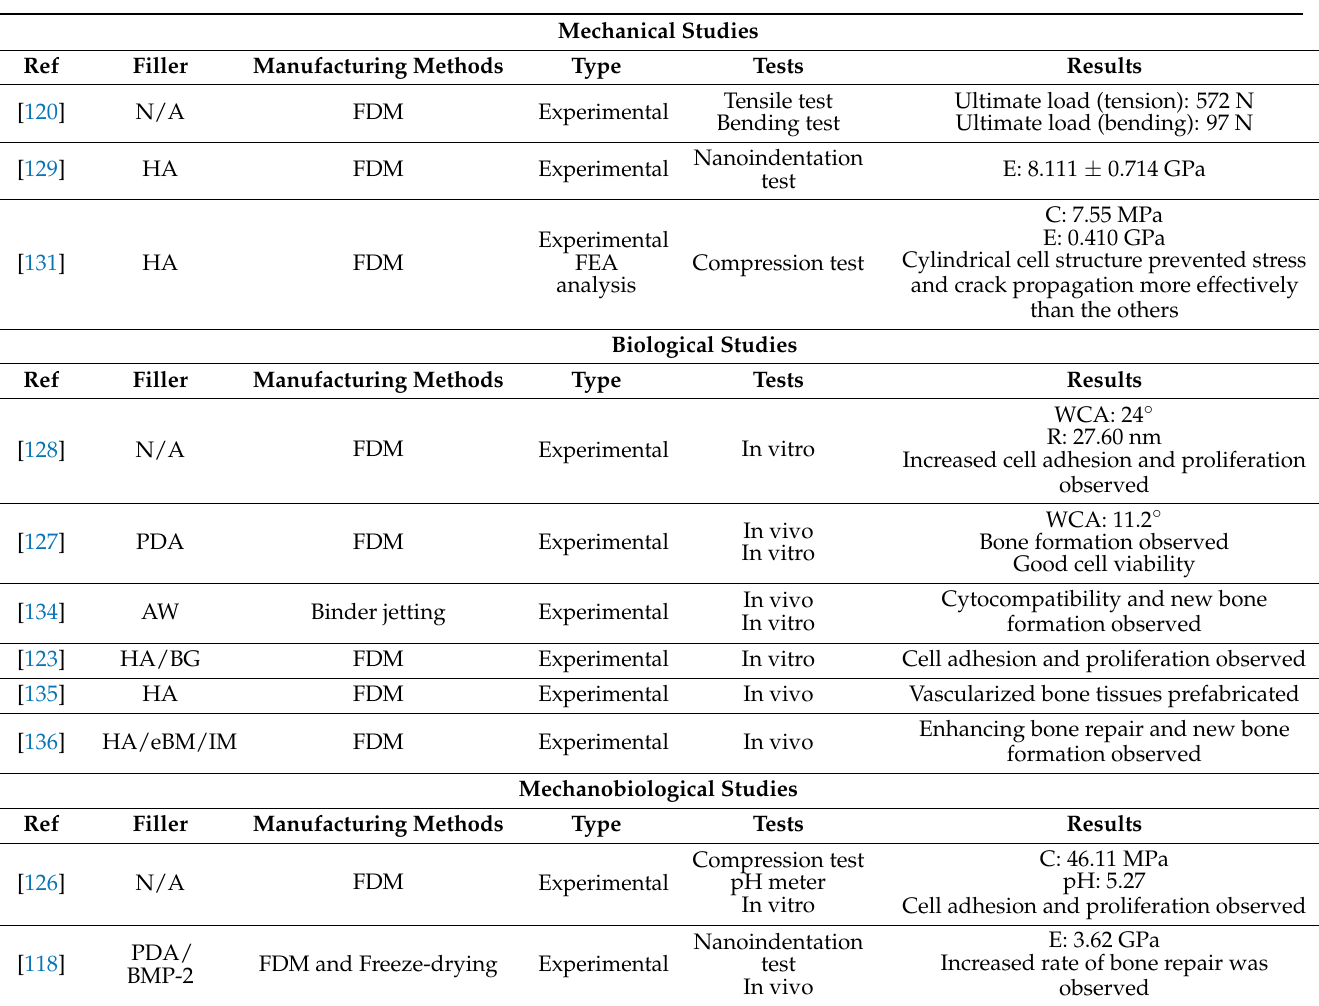
Table 3. Mechanobiological literature of PLA and its composite material; C: compressive strength, T: tensile strength, D: displacement, Y: yield strength, E: modulus of elasticity, WCA: water contact angle, B: bending strength, R: